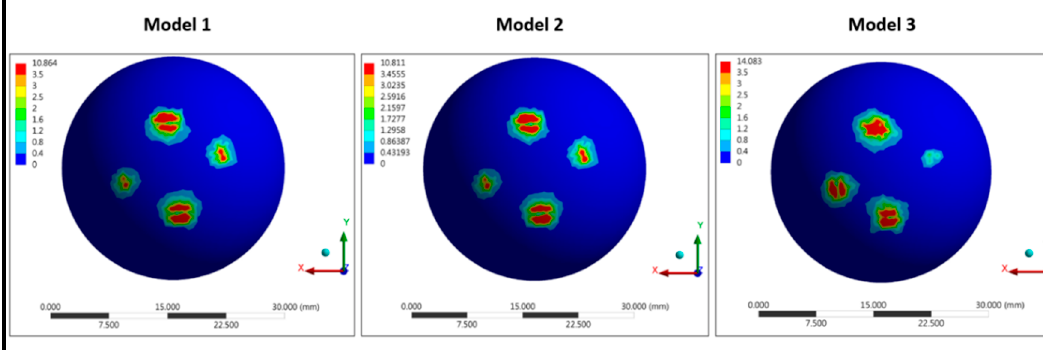
Figure 4. The distribution of von Mises stress on the